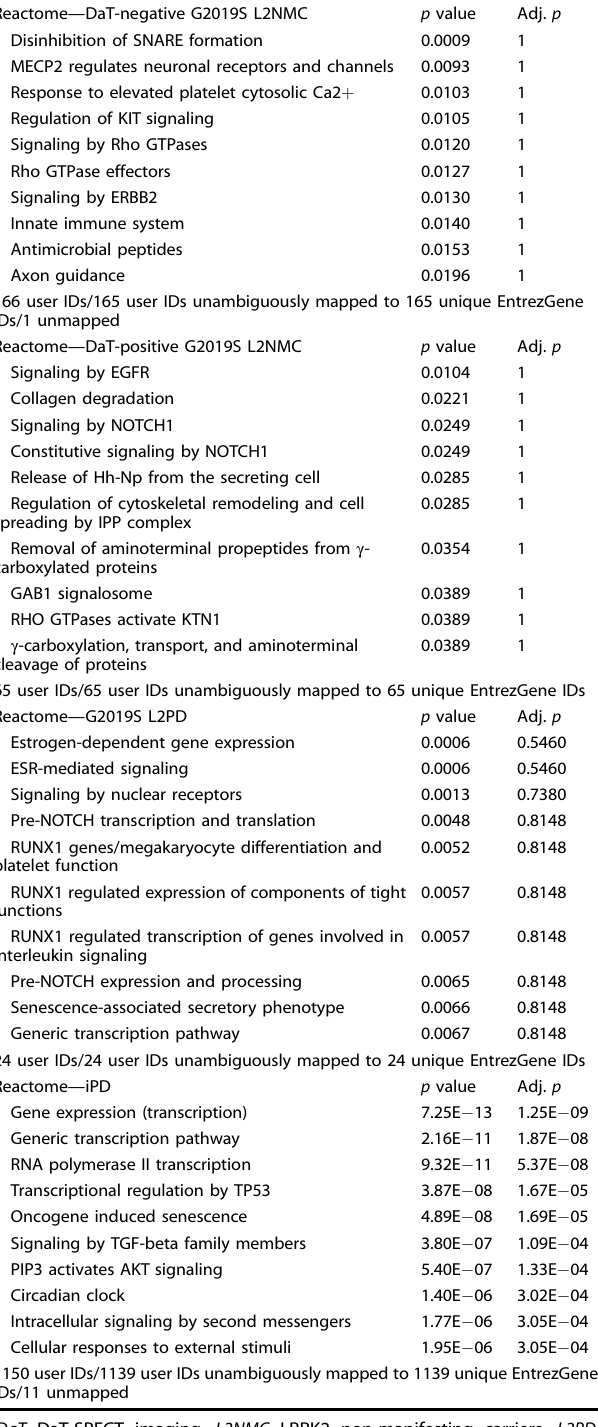
Table 4. Biological enrichment analysis of experimentally validated target genes from the top 10 DEmiR from discovery analysis in all main cross-sectional study